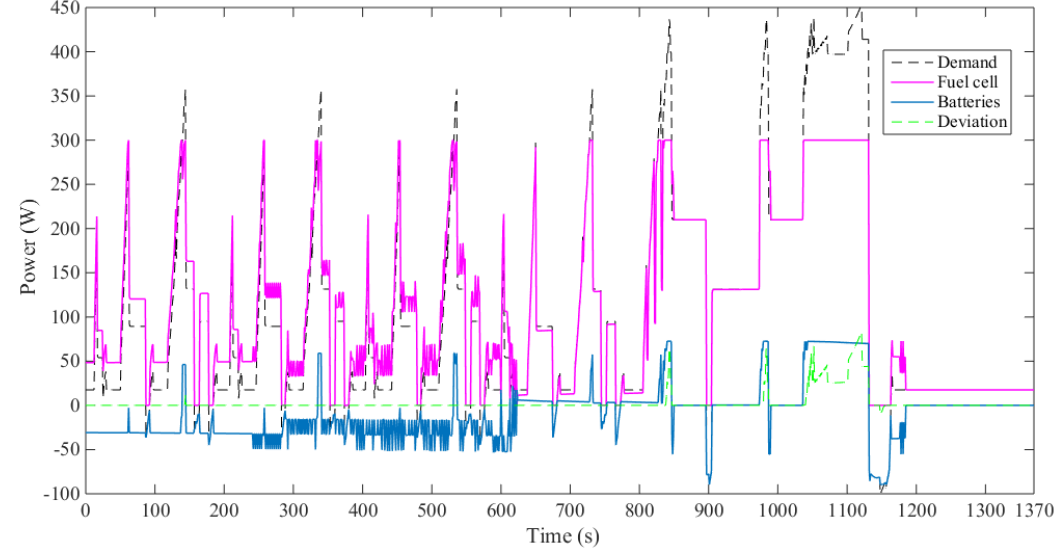
Figure 10. The power demand and the output power of each energy source.